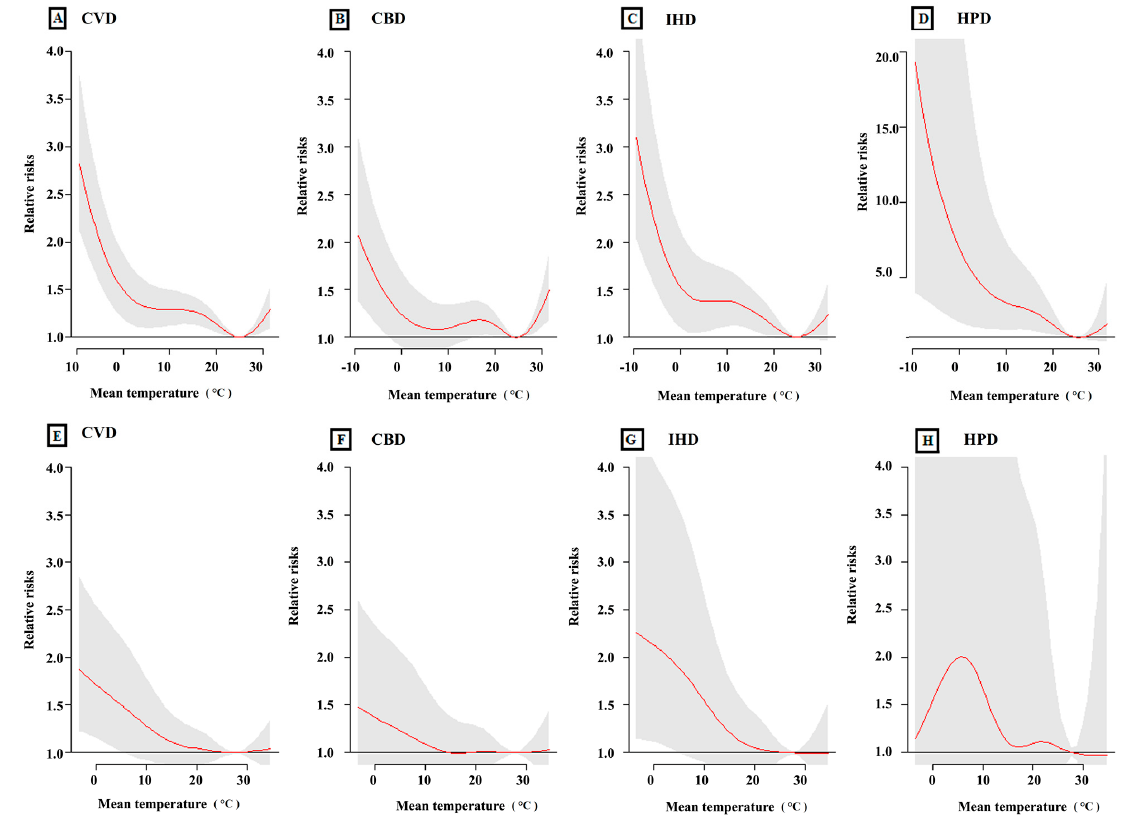
Figure 2. The relationship between mean temperature and cause-specific cardiovascular mortality over lag 0–27 days in Beijing and Shanghai, China, during 2007–2009. ( A – D ) The relationship between mean temperature and CVD, CBD, IHD and HPD in Beijing, respectively; ( E – H ) The relationship between mean temperature and CVD, CBD, IHD and HPD in Shanghai, respectively. The maximum likelihood estimate of relative risks is shown as smooth red lines, and the point-wise 95% confidence intervals are shown in the gray regions.